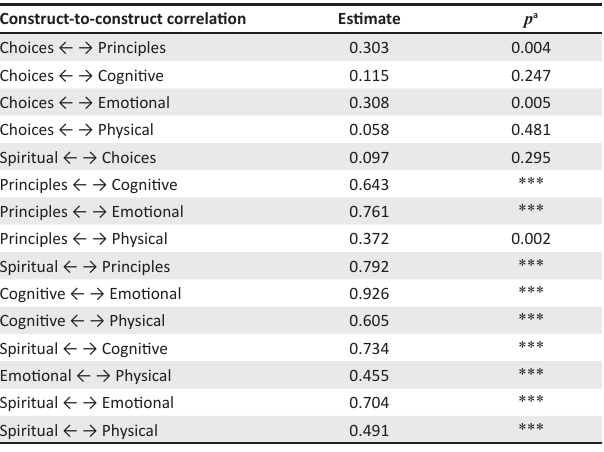
TABLE 4 : Standardised regression weight results. TABLE 5 : Construct-to-construct correlation results.